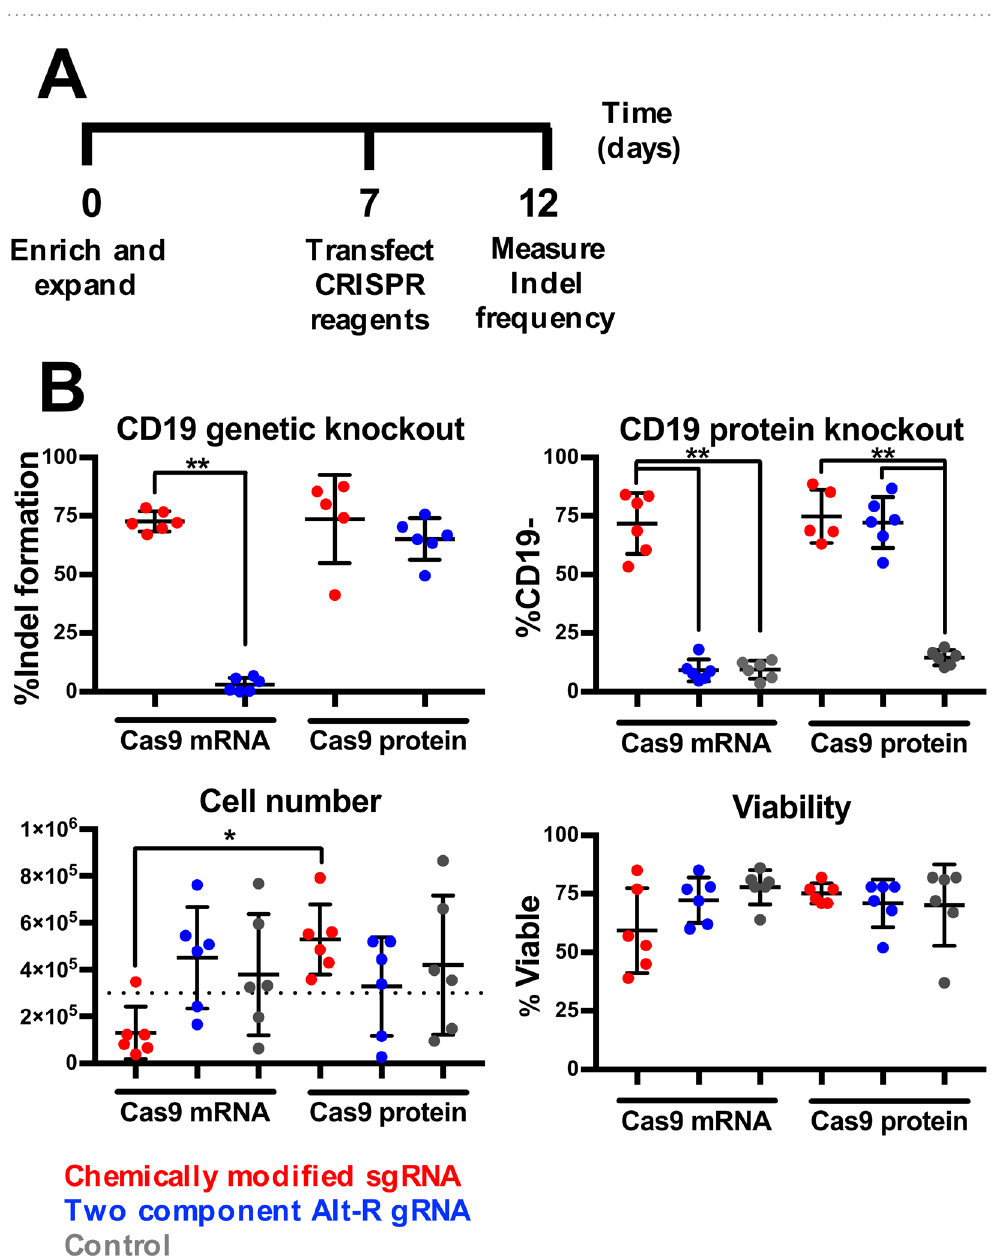
Figure 4. B cells are efficiently edited by CRISPR/Cas9. ( A ) B cells were enriched and isolated, electroporated with either chemically modified sgRNA or Alt-R gRNA in combination with either Cas9 protein or chemically modified mRNA encoding Cas9 protein, and then assessed for indel formation (n = 6). ( B ) Frequency of indel formation as measured by TIDE analysis ( left panel ) and loss of CD19 expression as measured by flow cytometry ( right panel ), viability ( left panel ) and total cell numbers ( right panel ) ( * indicate p < 0.05) (n =